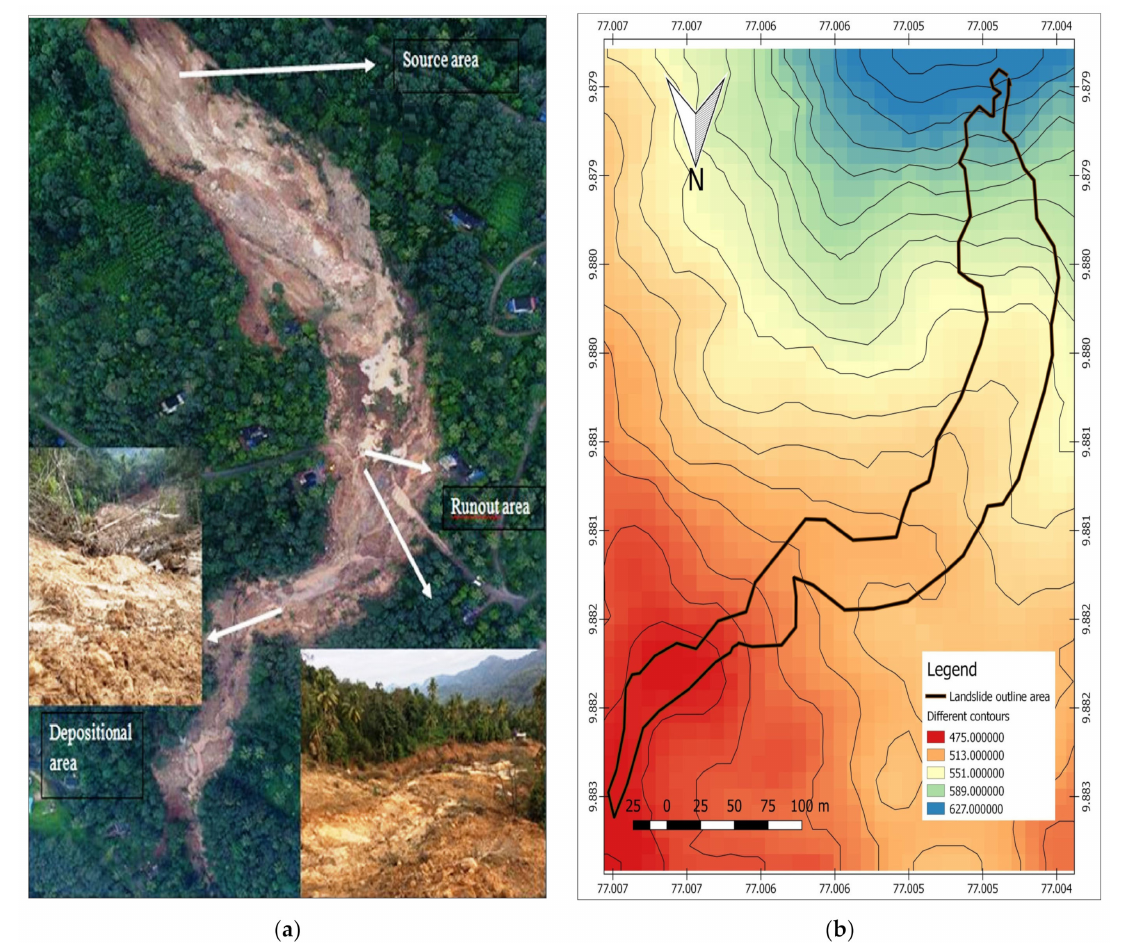
Figure 3. Landslide area with ( a ) aerial view of the source, runout and depositional area and ( b ) contour map.